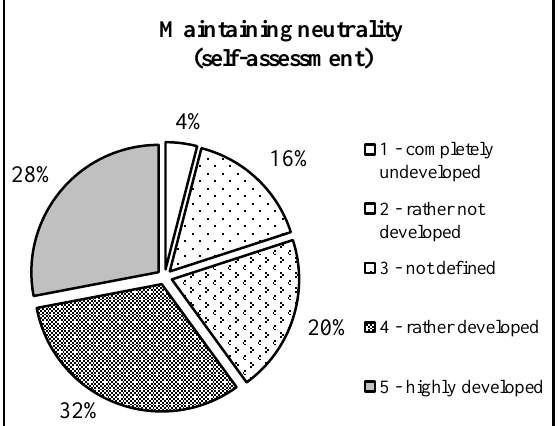
Figure 3. Expert’s position to the maintaining neutrality